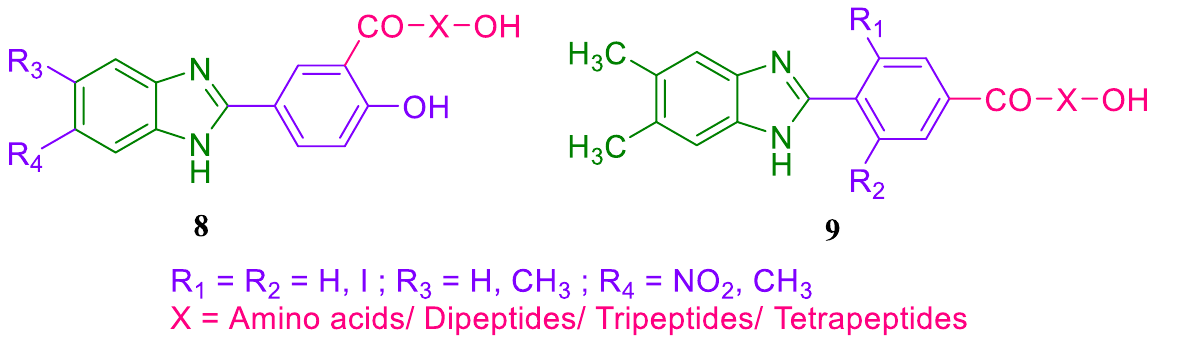
Figure 18. Benzimidazolo-peptide conjugates.